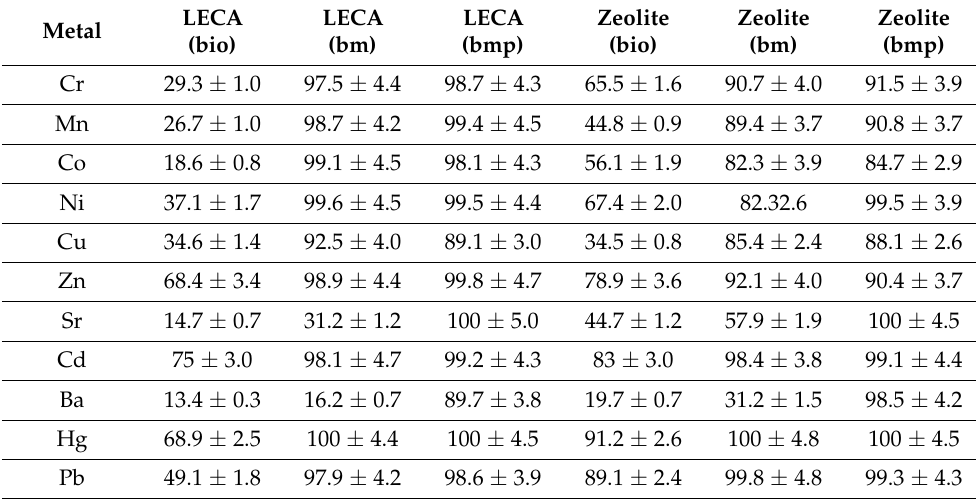
Table 4. Efficiency (%) of metal immobilization on materials in biomineralization experiments with phosphates (bmp) and without phosphates (bm).